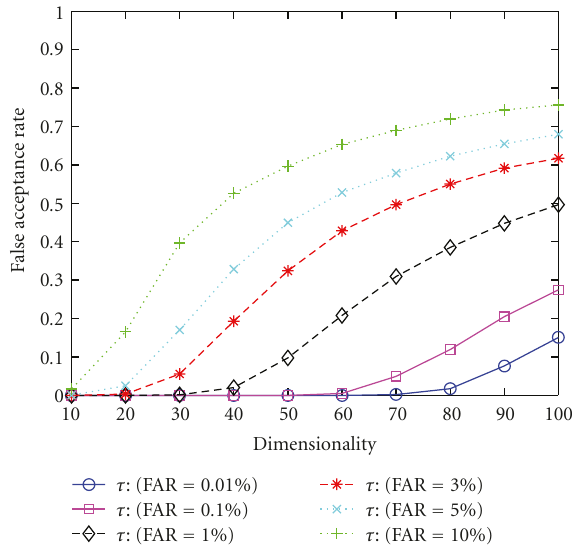
Figure 10: Experimental results based on reconstructed